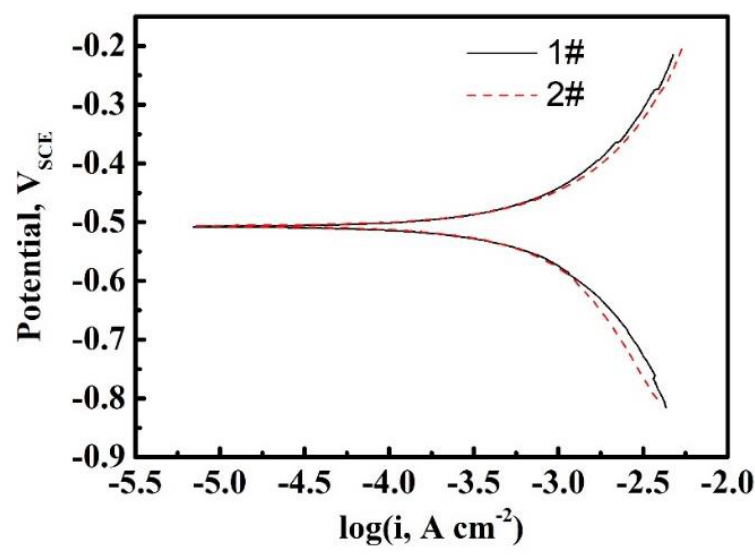
Figure 2. The potentiodynamic polarization of 1# and 2# steel in 0.05 mol/L H 2 SO 4 at 25 °C.